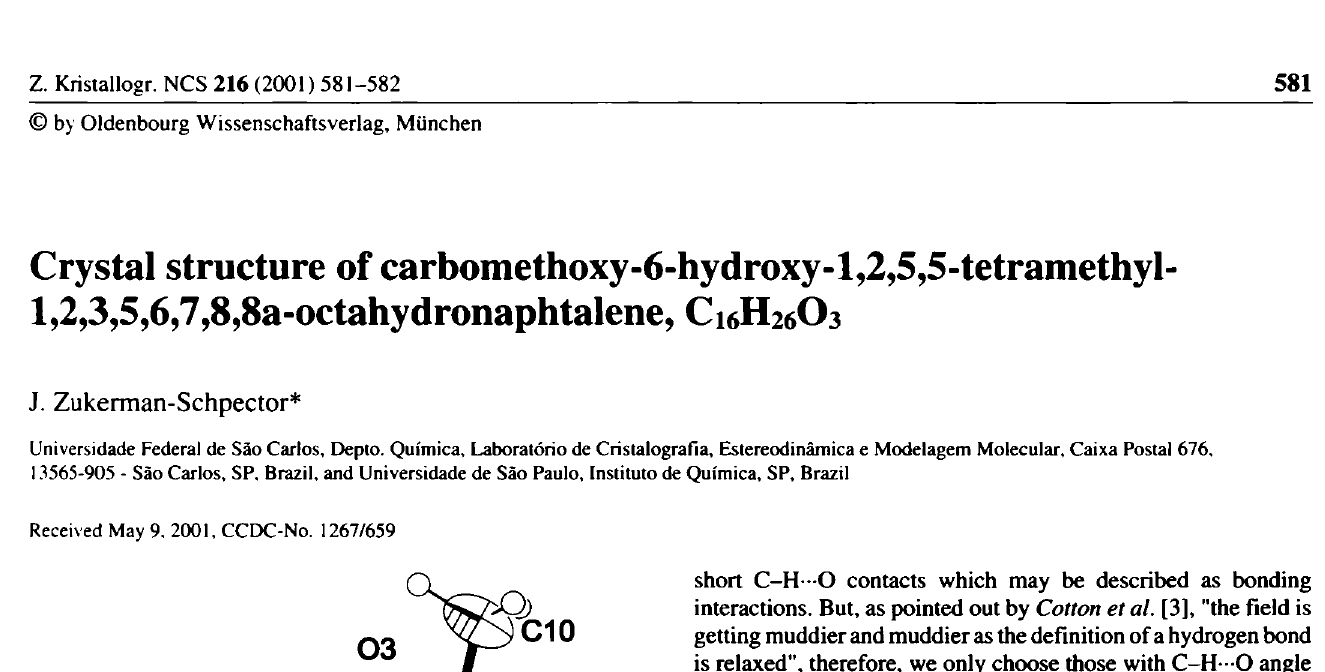
Table 1. Data collection and handling.